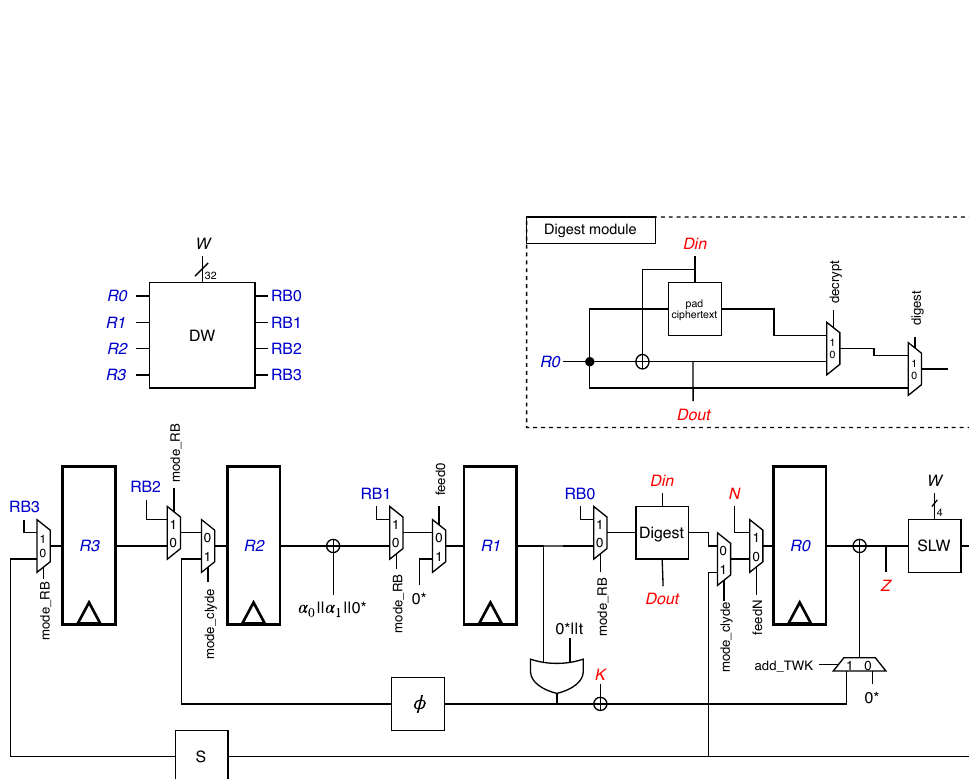
Figure 12: Architecture of Spook[128,512,su] v2 (unprotected, inverse-free